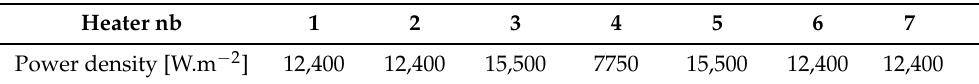
Table 8. Power densities for deicing Case